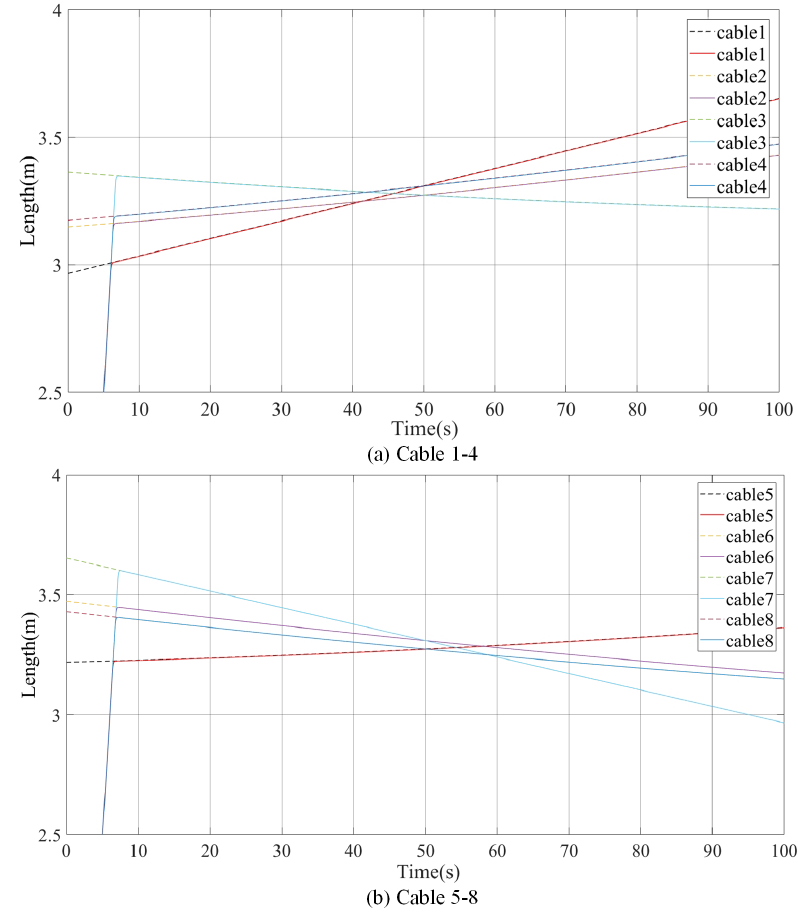
Figure 20. Projection and error of space track on each